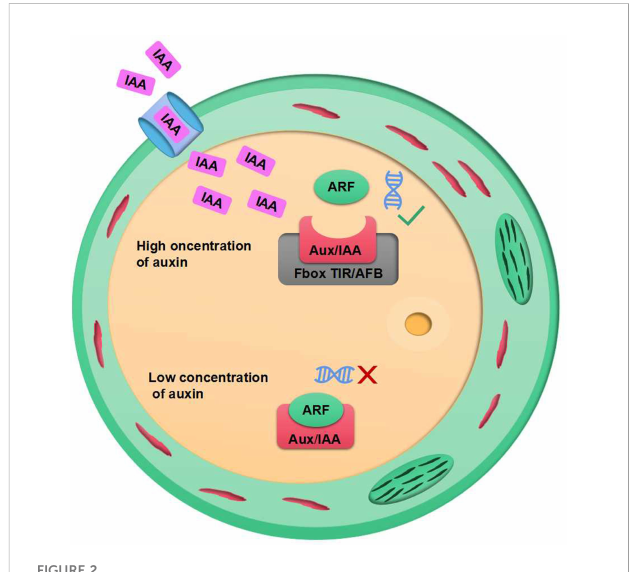
FIGURE 2 IAA signalling and gene expression system.